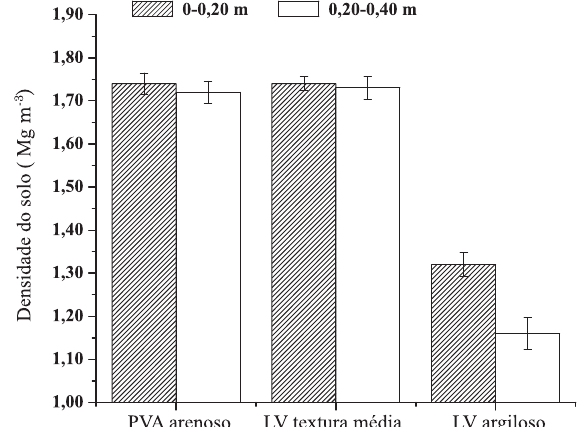
Figura 1. Valores médios de densidade do solo no PVA arenoso, LV textura média e LV argiloso nas duas camadas estudadas. As barras indicam o intervalo de confiança entre camadas (95